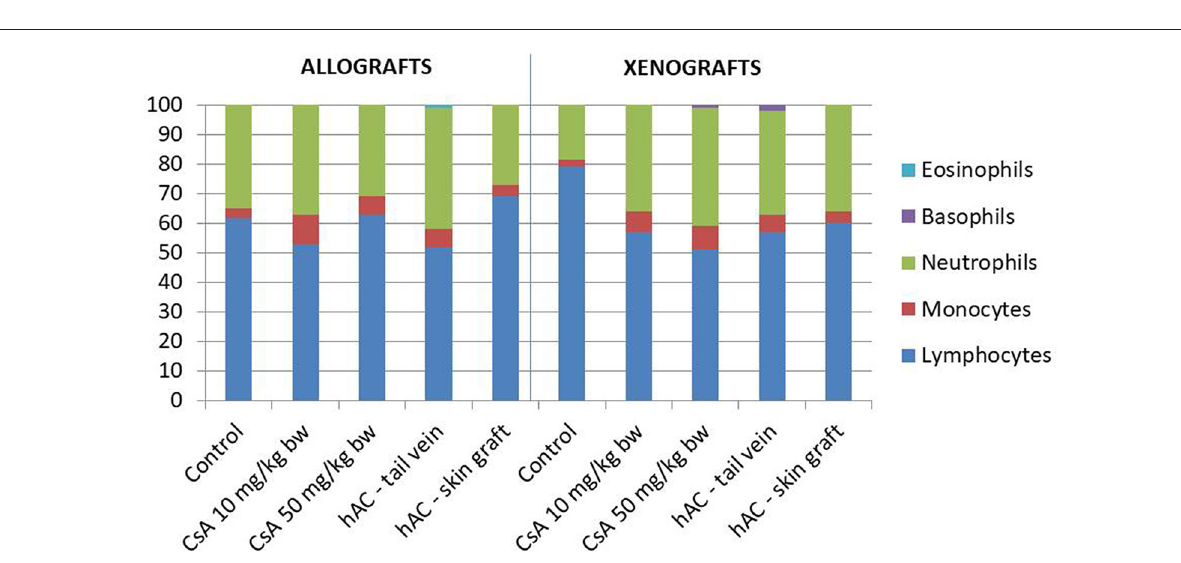
Frontiers in Medicine |